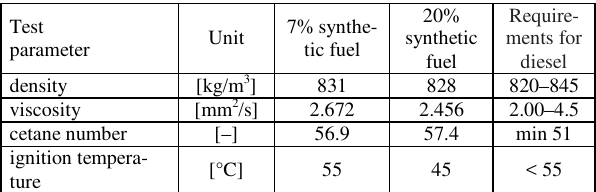
Table 3. Selected physico-chemical parameters 7% and 20% synthetic fuel mixture and diesel